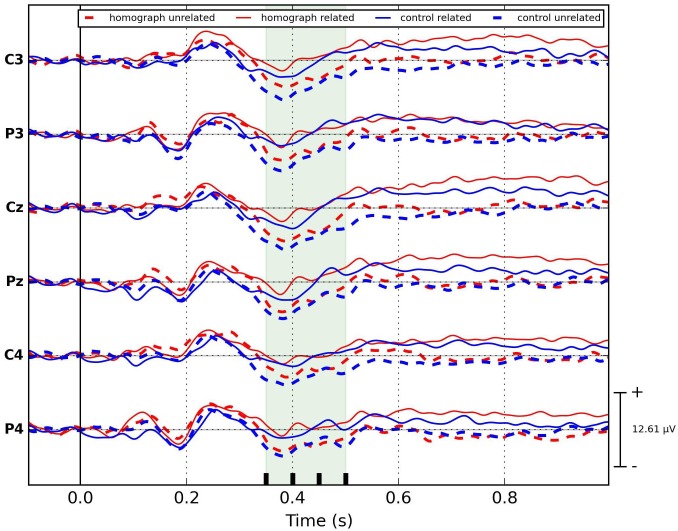
ERP plots for all stimulus groups for long experimental version.N400 time range is shaded. No priming effect is present for the homograph unrelated stimulus group.